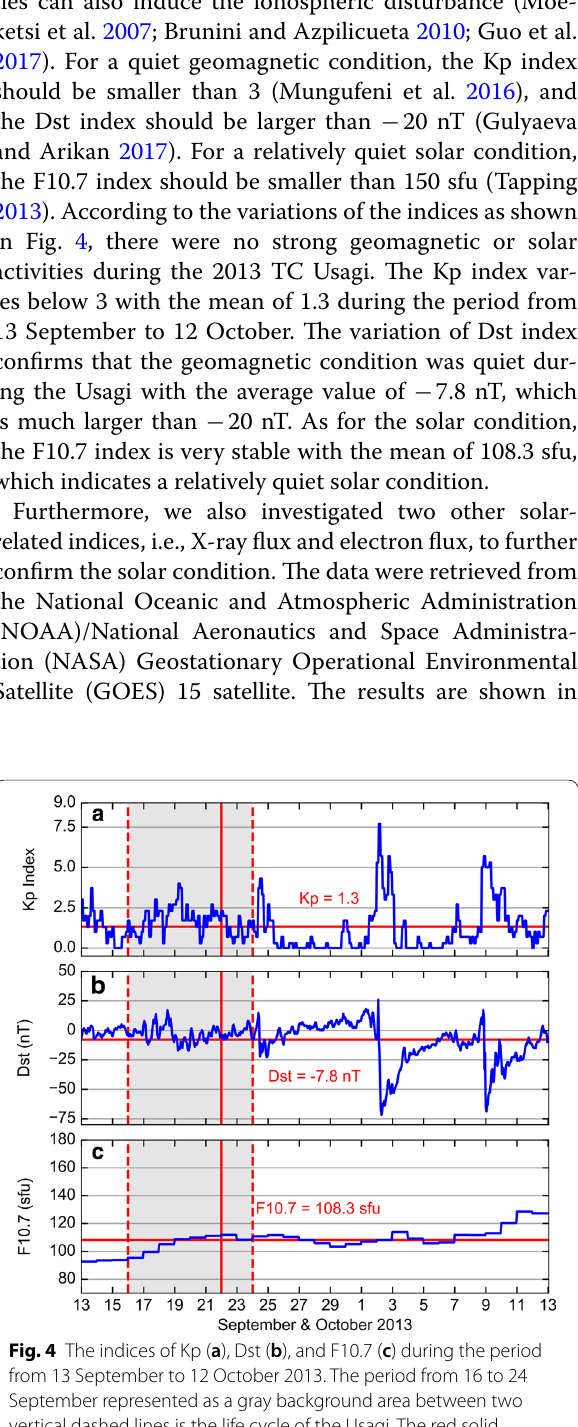
Fig. 5. The X-ray flux measured at the wavelength of 0.1–